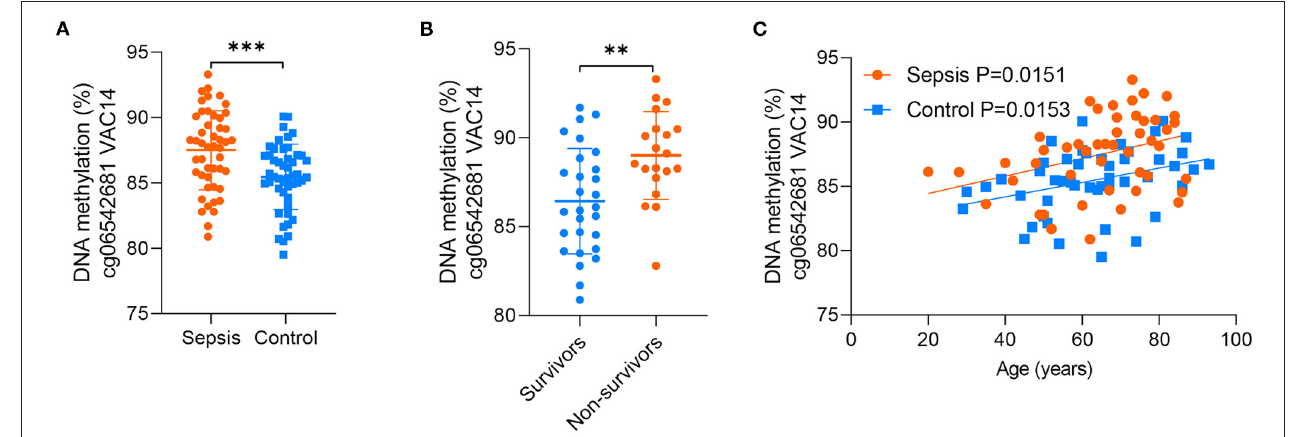
FIGURE 6 | Validation of the CpG site in VAC14. (A) DNA methylation of the CpG site in VAC14 in peripheral samples from 48 sepsis patients and 48 controls were analyzed by the pyrosequencing assays. (B) 48 sepsis patients were divided into two groups (28 survivors and 20 non-survivors) according to their hospital outcomes. (C) Correlation between age and methylation of the CpG site in VAC14 as analyzed by linear regression analysis. Data shown are mean ± SD. ** P < 0.01, *** P < 0.001. Comparisons between two groups were done by student’s t-test.